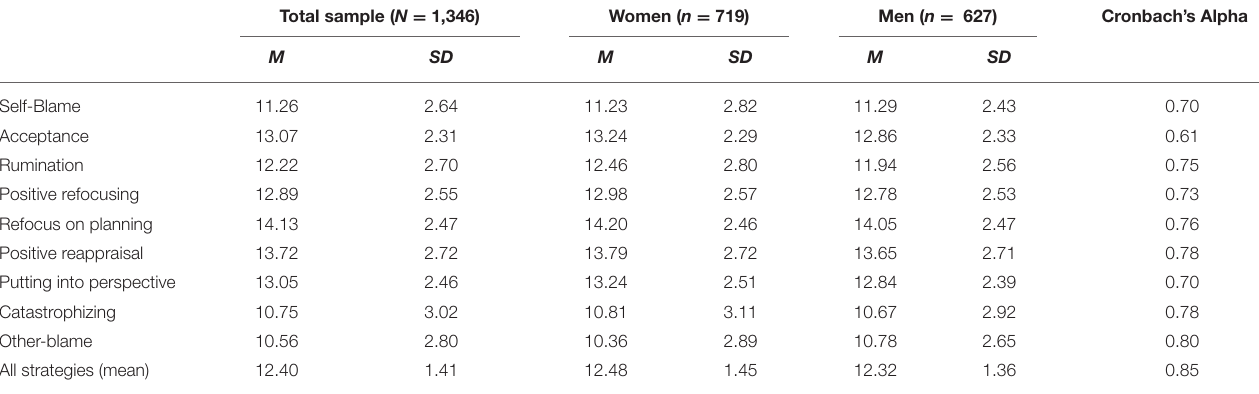
TABLE 4 | Means, standard deviations, and Cronbach’s Alphas of the Cognitive Emotion Regulation Questionnaire in the total sample and in the women and men